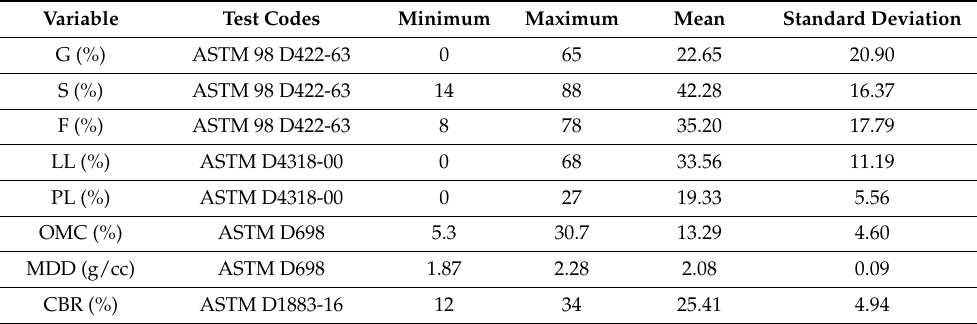
Table 2. Statistical data of input and output